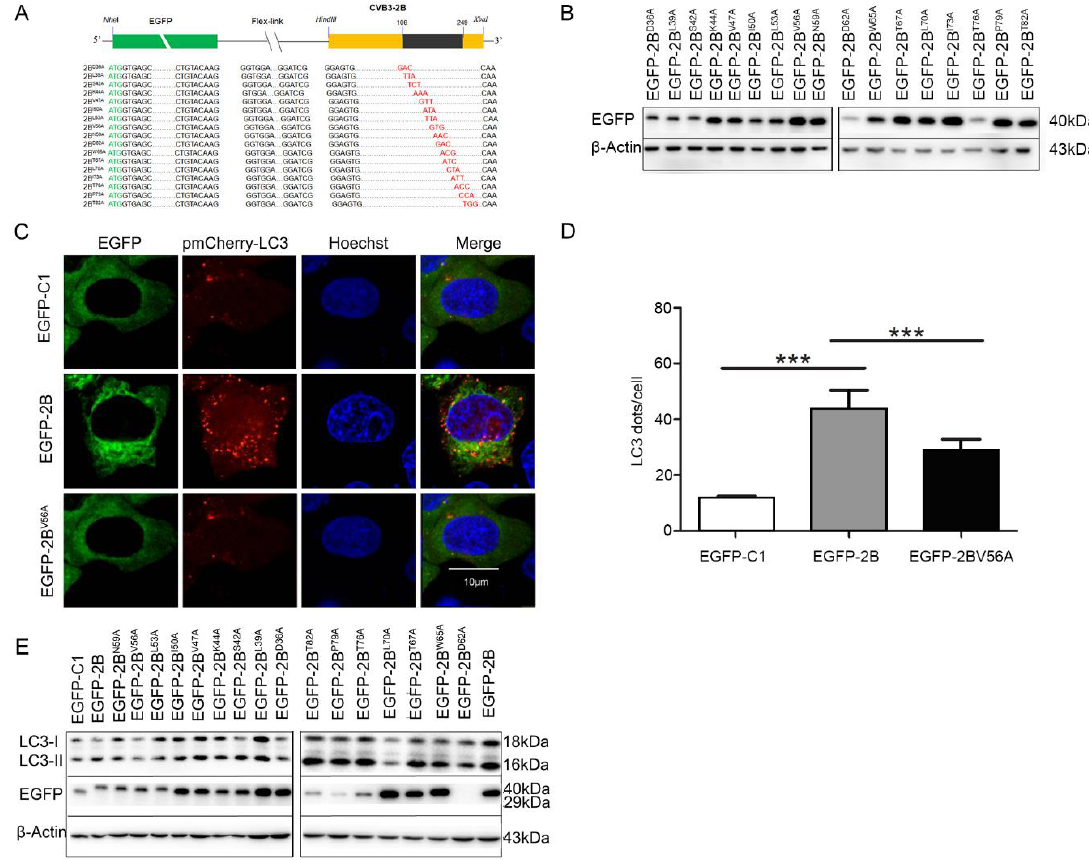
Figure 4. Mutated 2B V56A failed to induce autophagy. ( A , B ) Plasmids expressing EGFP-mutated 2B with single amino acid substitution were generated by site-directed mutagenesis. The expression of 2B mutants were analyzed by Western blotting; ( C ) HeLa cells were co-transfected with pEGFP-2B V56A , which expresses the mutant 2B (56V → A) fused with EGFP, and pmCherry-LC3 for 42 h and treated with E64-D/PEPA at 10 ng/mL for 6 h. Control cells were co-transfected with pEGFP-C1 and pmCherry-LC3. Cells were observed by confocal microscope (×600); ( D ) the statistic results show LC3 puncta in each cell from the results of ( C ). *** p < 0.01. Data are derived from 15 cells for each sample; ( E ) HeLa cells were transfected with pEGFP-2B mutant for 42 h and treated with E64-D/PEPA at 10 ng/mL for 6 h. Control cells were transfected with pEGFP-C1. EGFP and LC3 were analyzed by Western blotting. n = 4. Experiment was repeated three times. Representative images were presented.